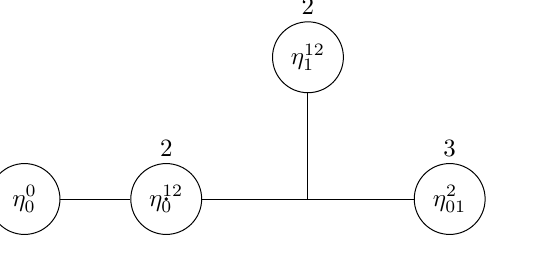
\ T \ V ( f ), Resolution 2 -model at S